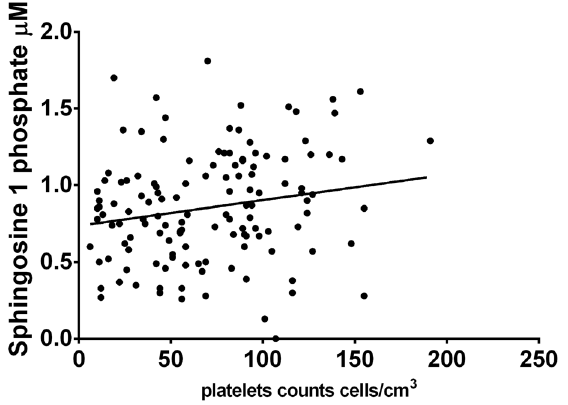
Figure 5. Correlation of serial serum S1P levels with serial platelet counts in patients with DF (n=10) and DHF (n=22). Spearmans r=0.18, p=0.04.